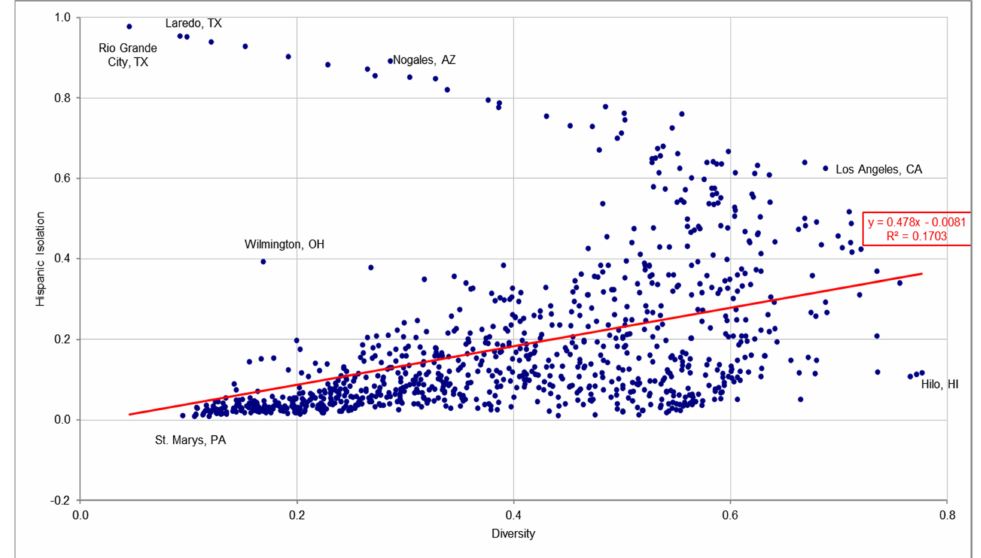
Figure 27. Relationship Between Diversity and Hispanic